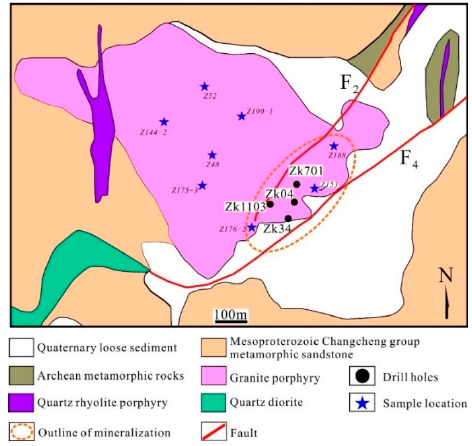
Figure 2. Geological map of the Xiajinbao gold deposit.